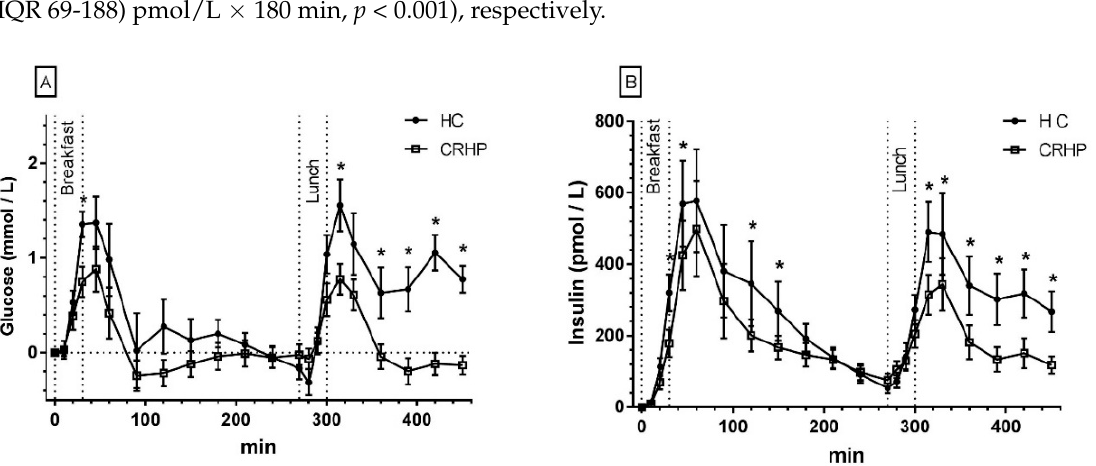
Figure 1. Mean ± SEM 7.5-h concentrations of glucose ( A ) and insulin ( B ) in 14 non-diabetic subjects after intake of a CRHP or HC breakfast and lunch, respectively (mean of two consecutive days on each diet). * Significant difference ( p < 0.05) between the HC and CRHP diet. HC: high carbohydrate; CRHP: carbohydrate-reduced high-protein.